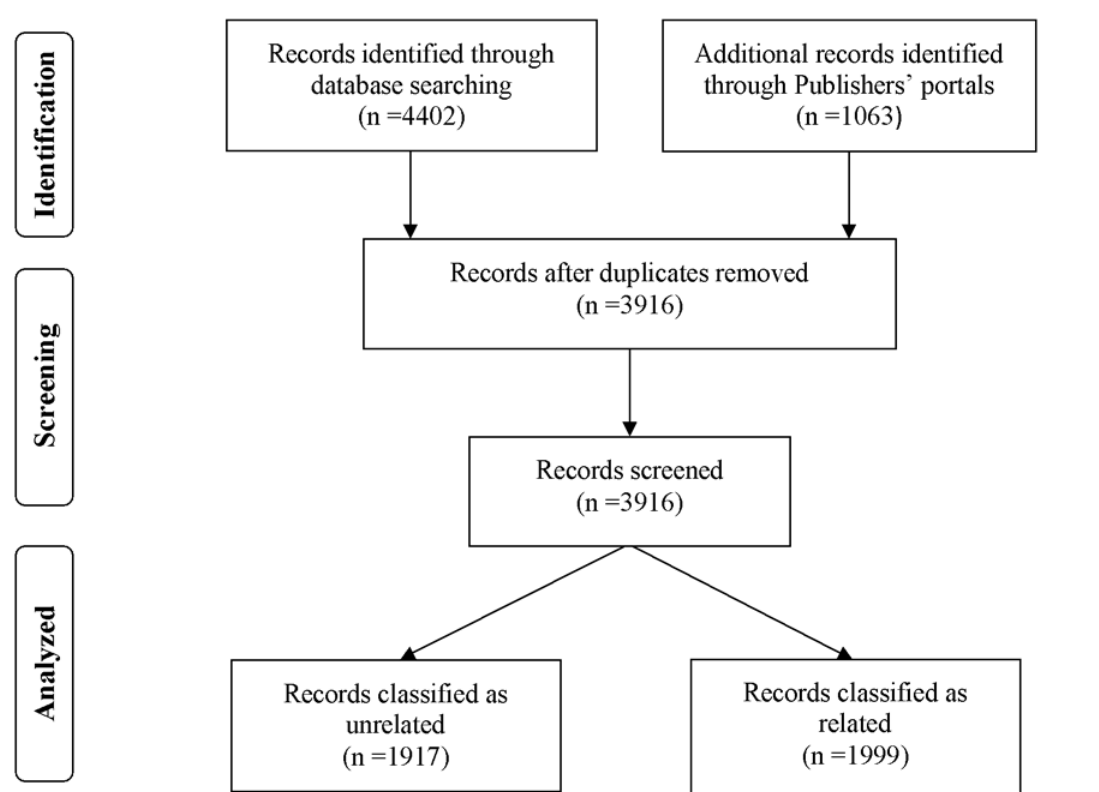
Fig 1. Self-medication flow